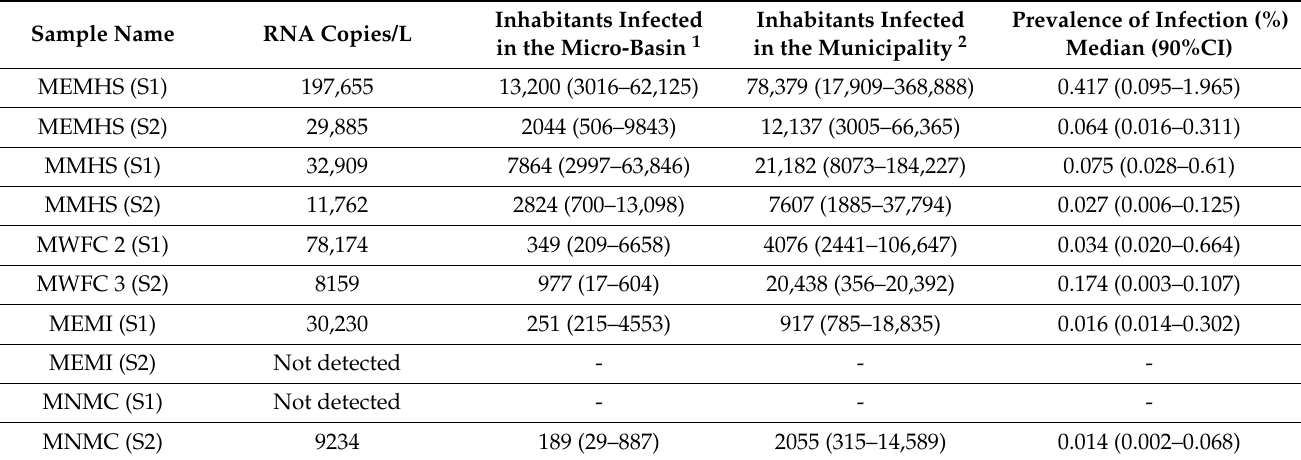
Table 2. Estimate of cases of infected people and prevalence based on the Monte Carlo model.